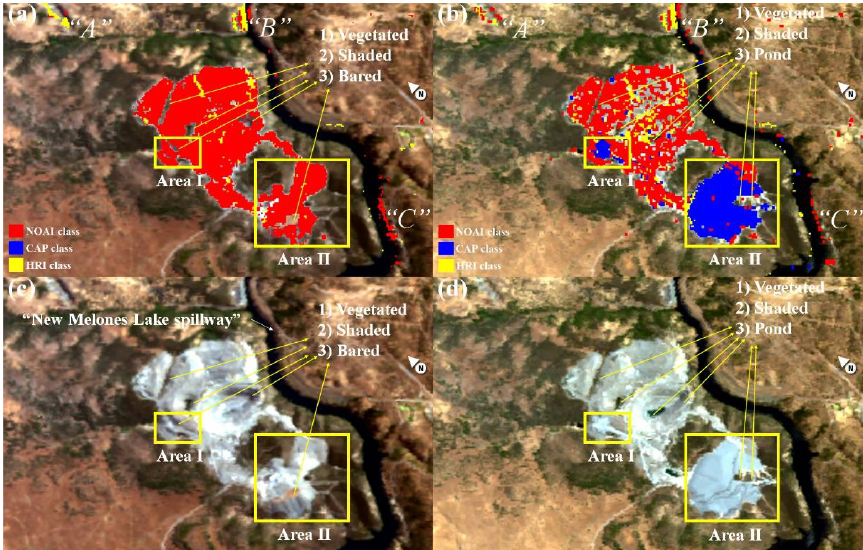
Figure 7. NOAI and CAP BLR models-based classification results in 2018 and 2014 (after and before treatment) AVIRIS images (true color images on the background are from 2018 ( a , c ) and 2014 ( b , d ) AVIRIS data). The red, blue, and yellow classes are assigned to NOAI, CAP, and HRI models, re- spectively. Areas I and II in a rectangle are specifically remediated regions. Yellow arrows indicate non-classified locations by models, which are composed of a pond, vegetation, and shaded-bared surfaces. A white arrow indicates the New Melones Lake spillway in ( c ). The classes in A , B , and C regions represent class distributions outside of the mining area.